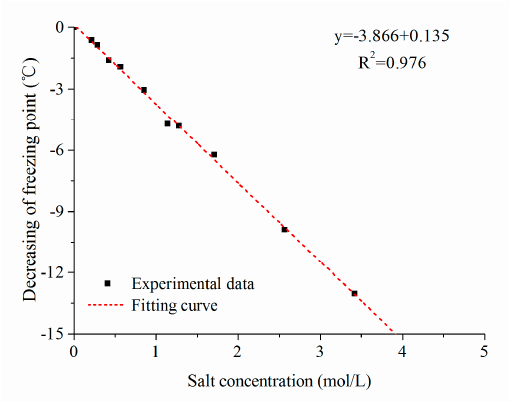
Figure 6. Influence of NaCl concentration on freezing point depression.